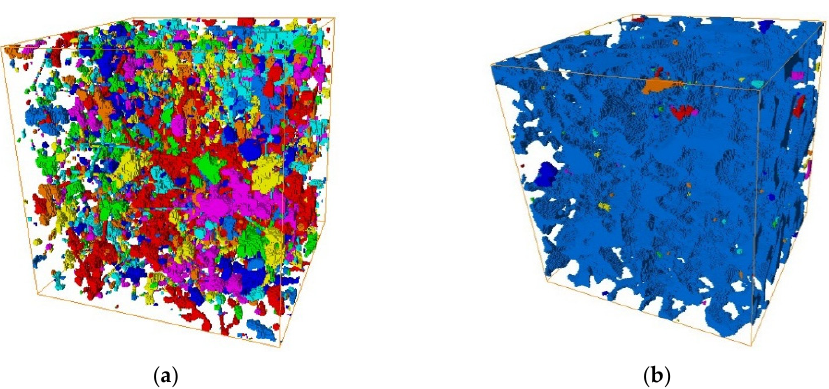
Figure 8. Pore space distribution: ( a ) pore space distribution of core 288-19; ( b ) pore space distribu- tion of core